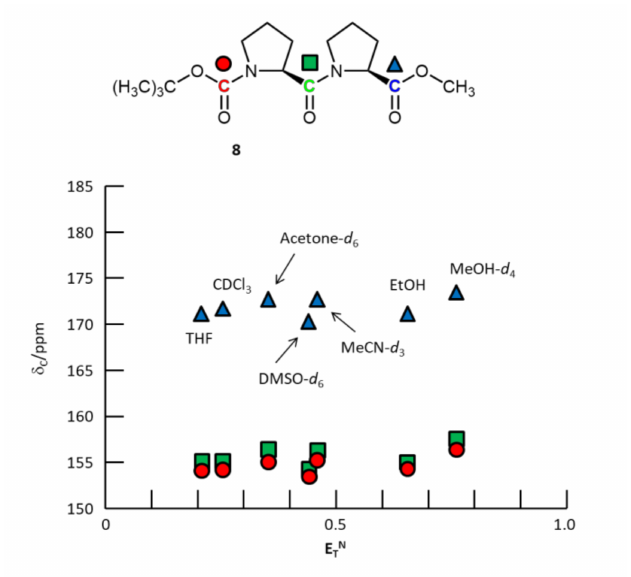
Figure 11. 13 C NMR chemical shifts of the carbonyl carbons of N -Boc-L-proline-L-proline-OMe 8 . In order to investigate the steric effect of the proline ring residue, the behavior of the 13 C NMR chemical shifts of the carbonyl carbons in the two dipeptides, N -Boc-L- alanine-L-proline-OMe 9 and N -Boc-L-serine-L-proline-OMe 10 in different solvents were investigated. Interestingly, when we measured 13 C NMR chemical shifts of the carbonyl carbons of N -Boc-L-alanine-L-proline-OMe 9 , all the three carbonyl carbons in 9 showed downfield shifts with the increase of the solvent polarity E T N values (Figure 12). This is an anticipated outcome as this case is similar to N -Boc-L-alanine-OH 1a or N -Boc-L-alanine- OMe 1b . In addition, this outcome also suggests that the peptide bond formed with the carboxyl group on the proline ring makes some contribution to the near-constant chemical shifts on the carbonyl next to the proline nitrogen